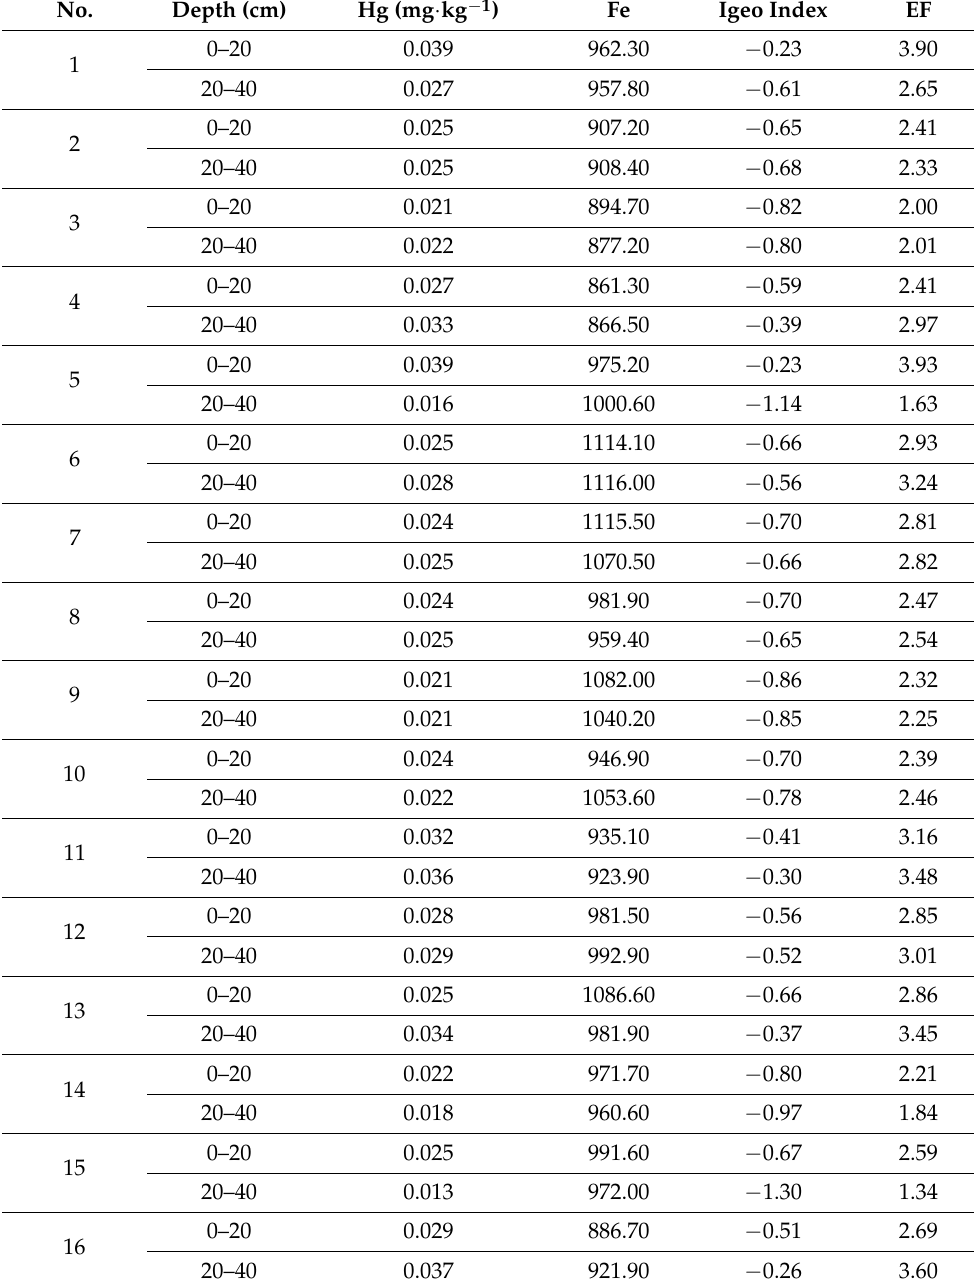
Table 2. The content of Hg and Fe. Calculated geo-accumulation indexes (Igeo) and enrichment factor (EF).